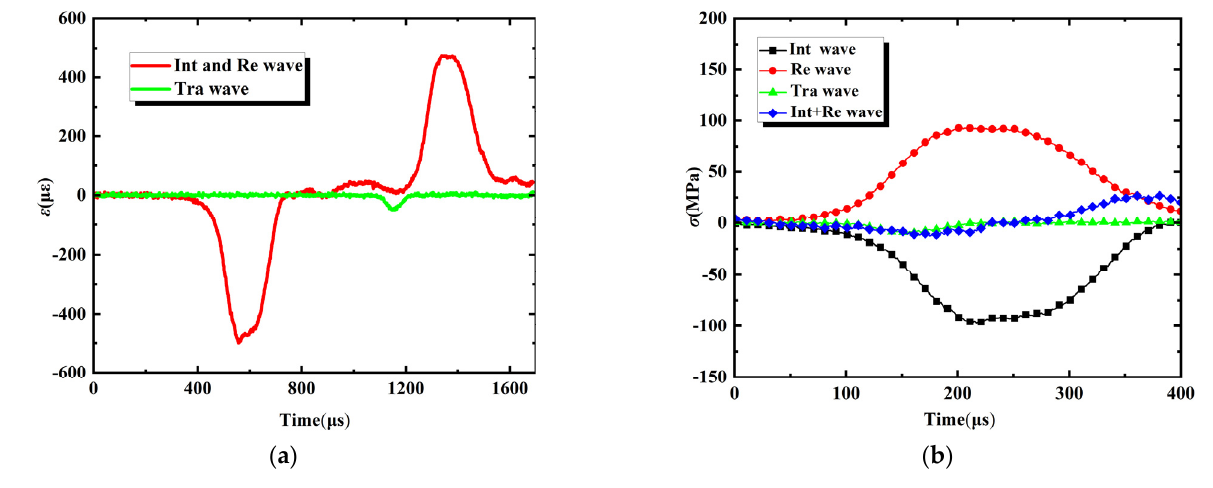
Figure 12. Waveforms and dynamic stress equilibriums of specimens in a typical flattened BD test (impact speed: 5.1 m/s). ( a ) Raw strain signals obtained from the strain gauges attached on the bars. ( b ) Dynamic force balance at both ends of the specimen.